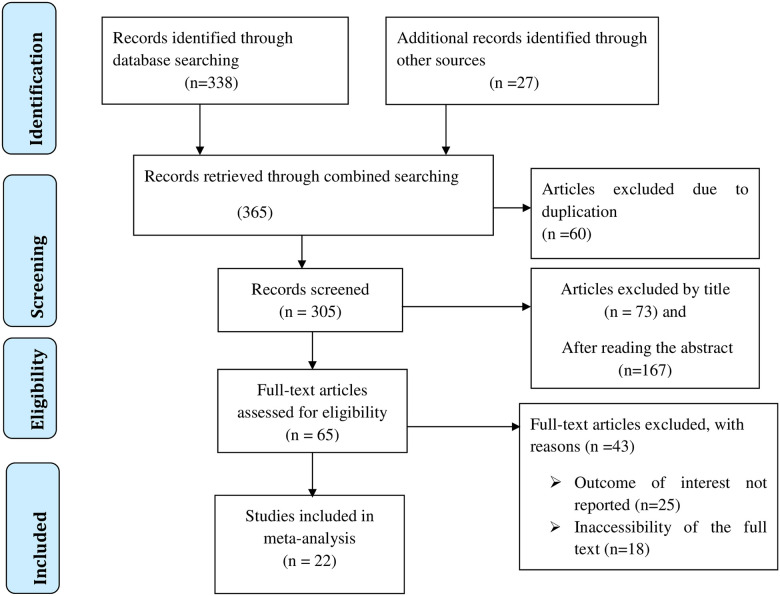
Flow chart of study selection for systematic review and meta-analysis on the prevalence and associated factors of intestinal parasitic infections among people living with HIV/AIDS in Ethiopia.